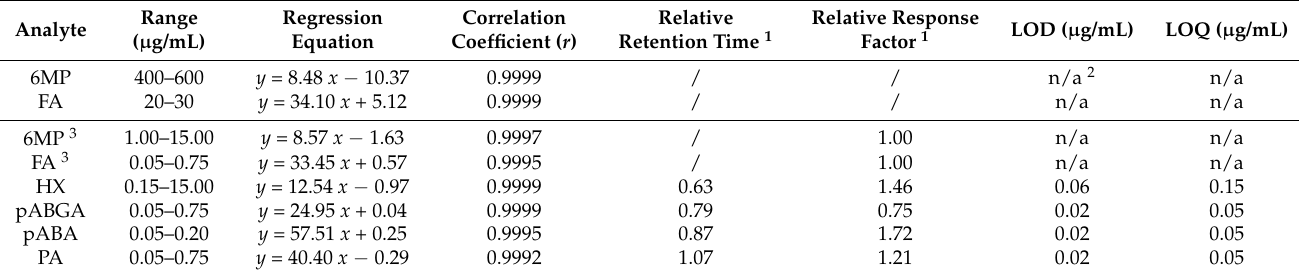
Table 1. Linearity of the developed chromatographic method. LOD: limit of detection, LOQ: limit of quantitation. Range Analyte ( µ